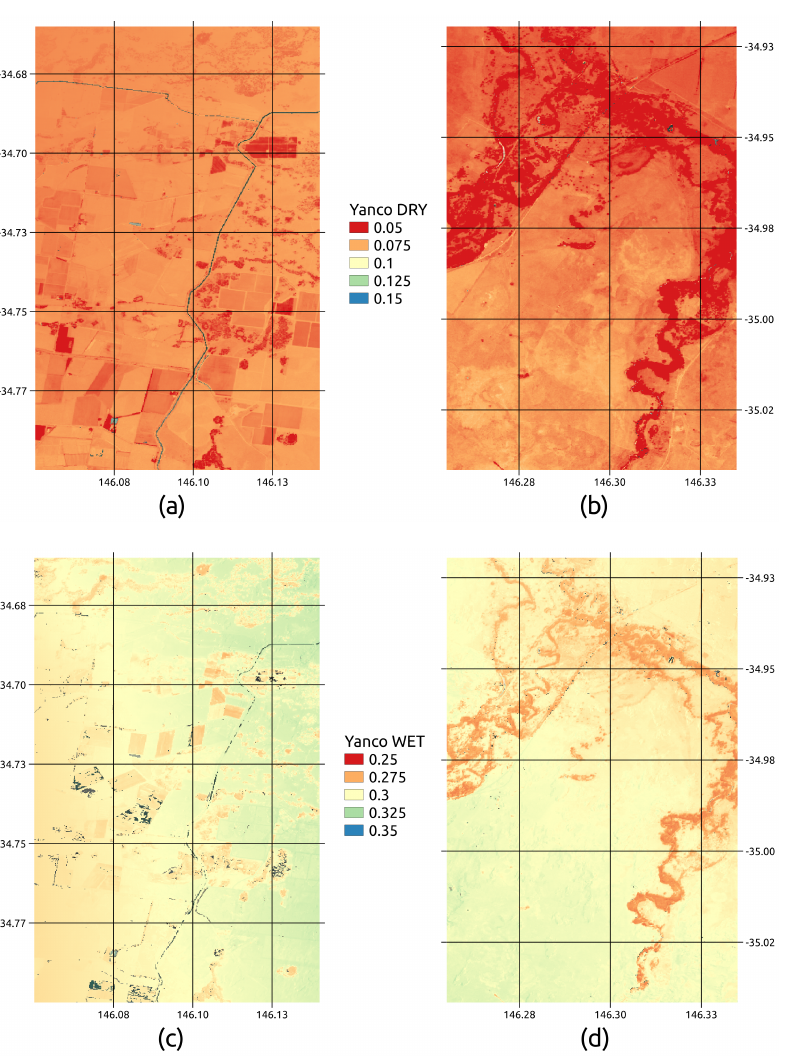
Figure 4. SM retrieved by the combination of SMOS SM and downscaled using Sentinel-2 NDVI. Dry flight at ( a ) Site A, and ( b ) Site B; and during Wet flight at ( c ) Site A, and ( d ) Site B. Credits: Barcelona Expert Center [52]. Note that the color scale is different in each plot to maximize the contrast and ease its visualization.